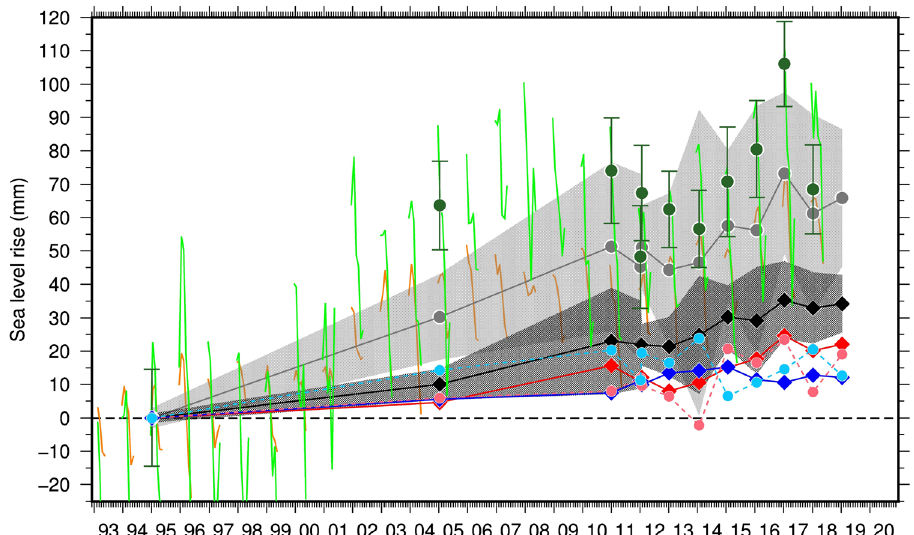
Fig. 3 Time-series of Sea Level Rise (SLR) estimated from the satellite altimeter and conductivity-temperature-depth (CTD) observations in the core region in the Australian-Antarctic Basin (core AAB). Time-series of SLR estimated from the satellite altimeter and CTD observations in the core AAB. Light green lines denote smoothed (30-d moving average) summer (January to March) satellite-observed SLR in the core AAB, and orange lines denote those of the overall Southern Ocean. Dark green circles with error bars denote 10-d means and standard deviations of the satellite-observed SLR in the core AAB over the study period, where the midpoint corresponds to the CTD observations. Grey circles and black diamonds with solid lines denote steric SLR for the entire water column and deep layers below 2000 m, respectively; the shaded area indicates the 95% con fi dence interval. Red and blue diamonds with solid lines denote deep layer thermo- and halosteric SLR, respectively. Pink and light blue circles with dashed lines denote thermo- and halosteric SLR in the shallow layer above 2000m, respectively. Two points are plotted for 2012 to re fl ect observations along 110°E and the I09s. Table 1 Steric and satellite-observed SLR in the study area.